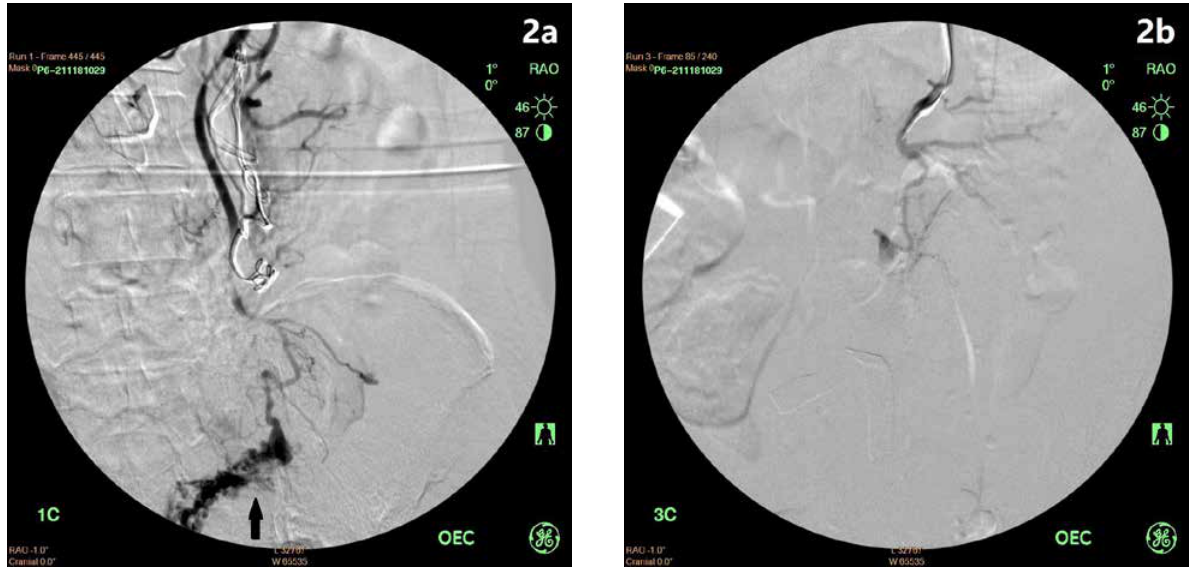
Figure 2: Rectal varices before and after foam injection. a) Rectal varices (arrow) at intra-operative angiography via inferior mesenteric vein. b) Occlusion of rectal varicose veins after injection of Polidocanol foam..